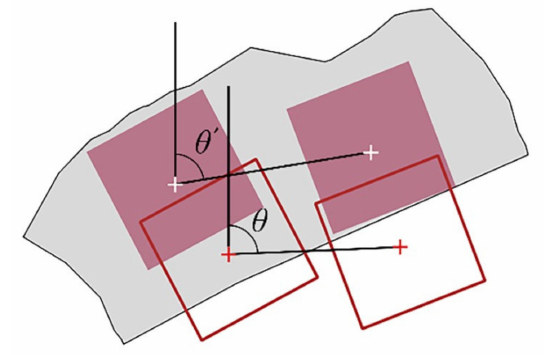
Figure 14. Azimuth difference.